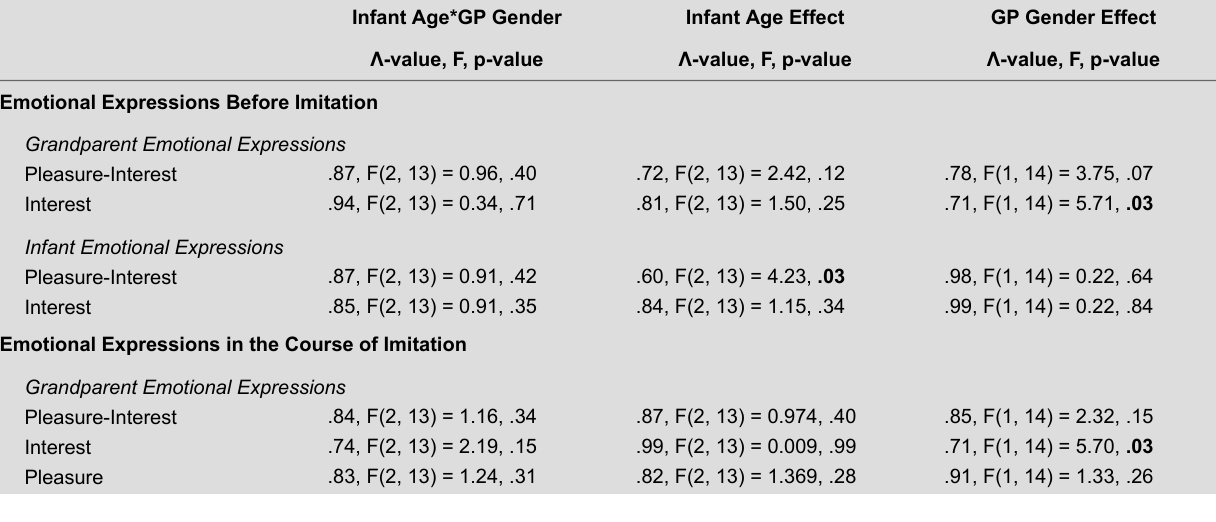
Summary Table of Longitudinal Analysis (Wilk’s Lambda) of Grandparent (GP) and Infant Emotional Expressions That Preceded, Accompanied and Followed Spontaneous Imitation in Dyadic Grandfather- and Grandmother-Infant Interaction